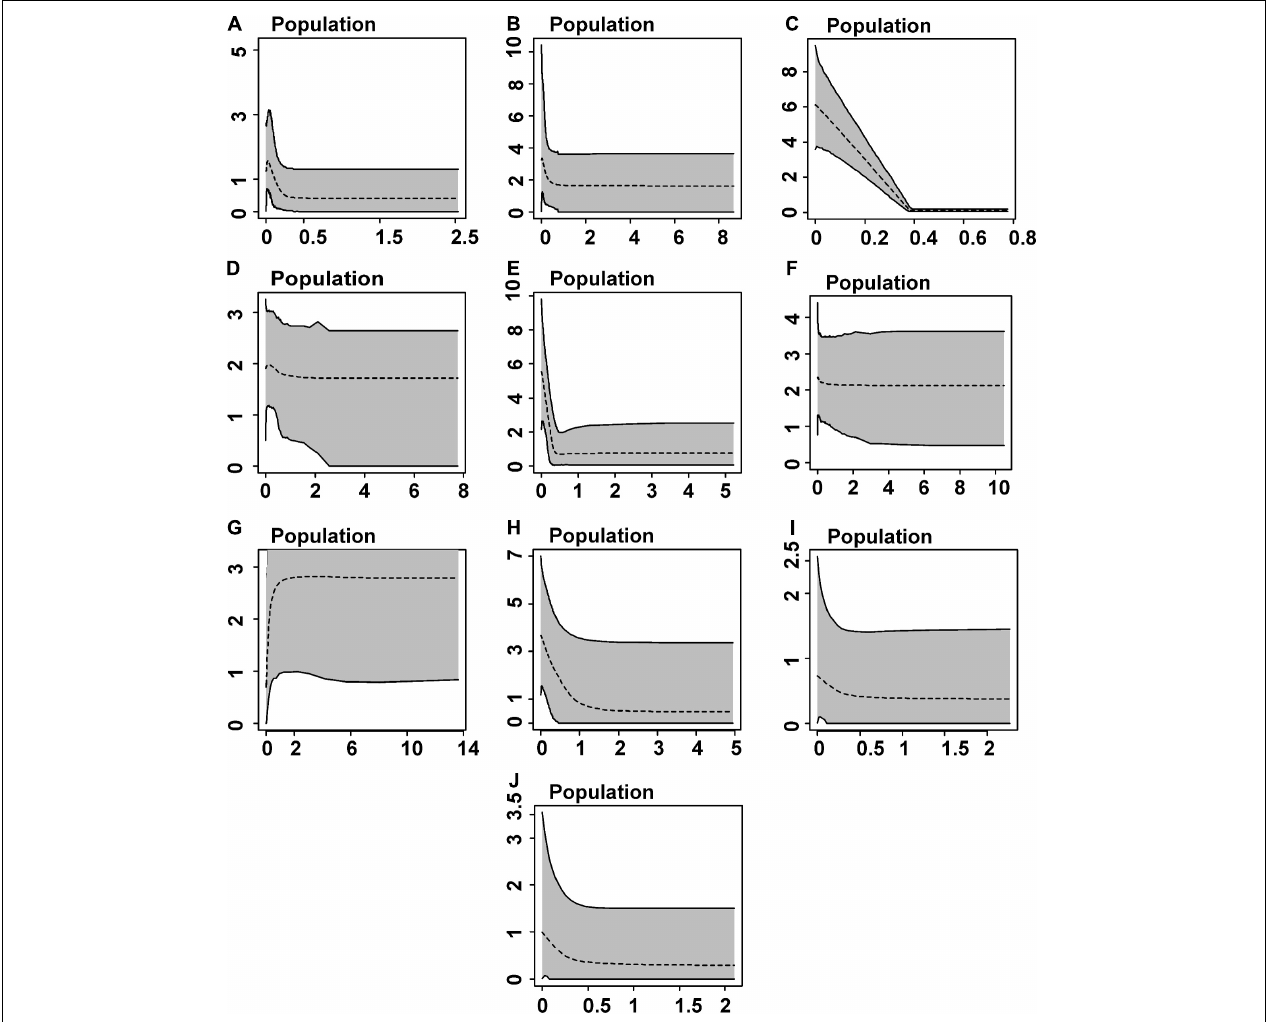
FIGURE 5 | Demographic history estimated by Extended Bayesian Skyline Plots based on mtDNA (CYTB and 16S), and nuDNA (DNAH3 and SINCAIP) for inferred Amazonian populations/lineages of Kentropyx calcarata . Dashed lines represent median values. The gray area corresponds to 95% confidence intervals. X -axis corresponds to time in millions of years before the present, and Y axis represents effective population size scales.